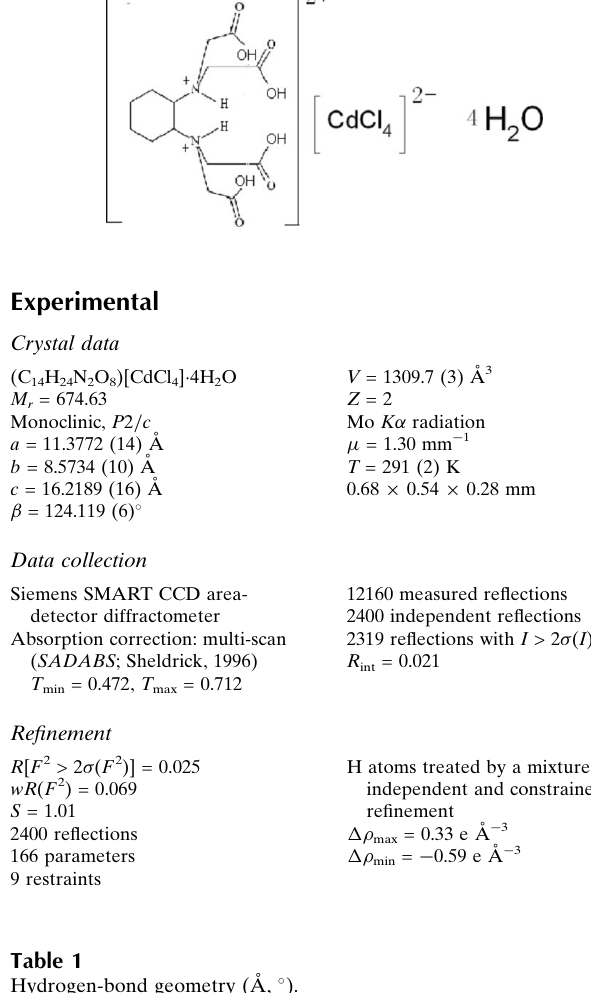
Hydrogen-bond geometry (A˚ , (cid:3) ). D —H (cid:1)(cid:1)(cid:1)